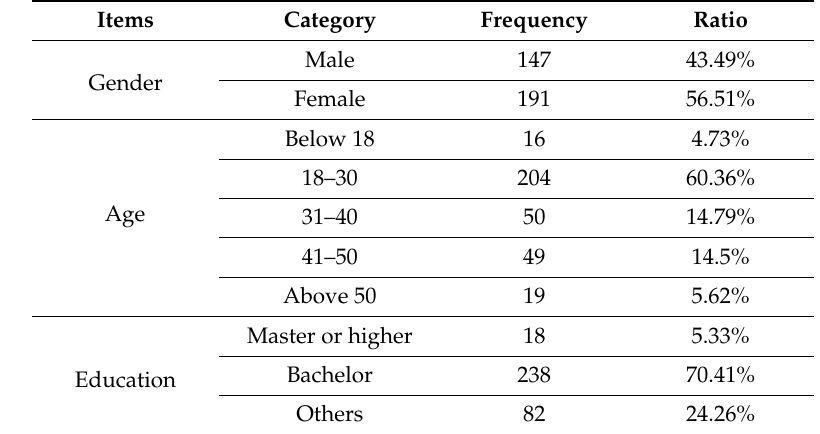
Table 2. Demographic information of respondents.